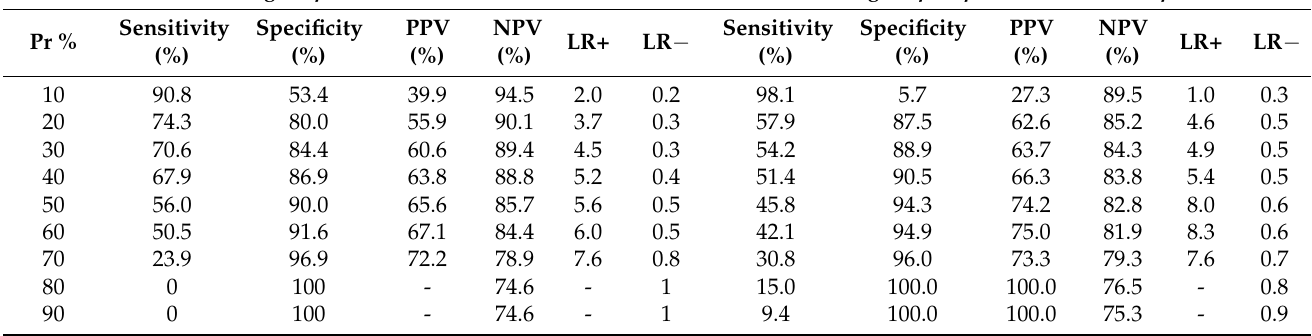
Table 3. Sensitivity, specificity, positive and negative predictive values (PPV and NPV), and positive and negative likelihood ratios (LR+ and LR − ) of the predictive model, including age, education, and baseline and one-year anxiety status to predict the High-up Anx vs. Mid-down trajectories and the predictive model including age, education, and baseline and one-year depression status to predict the High-up Dep vs. Mid-down Dep trajectories, according to different a priori probabilities (Pr) of these